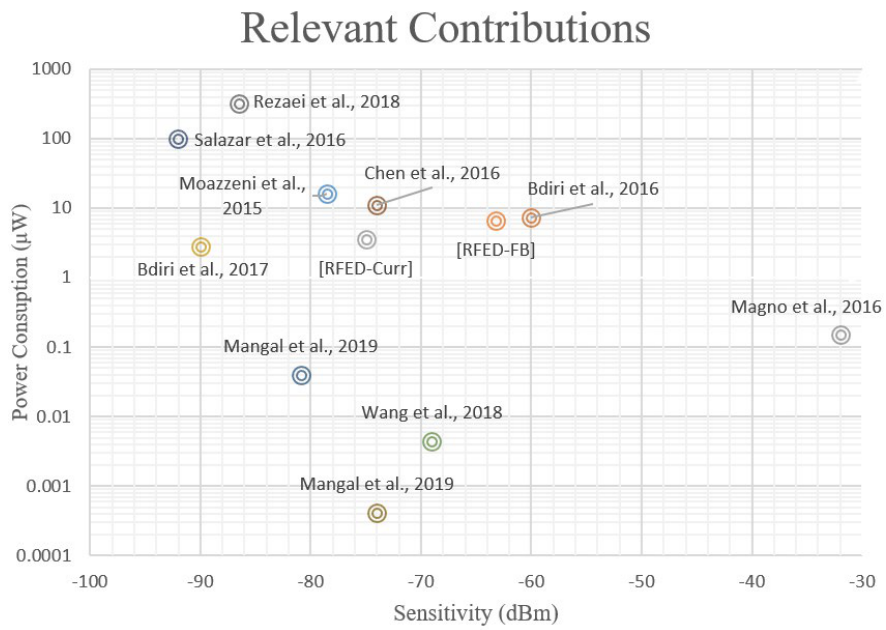
Figure 13. Representation of the performance of the proposed contributions along with some of the most relevant state-of-the-art works involving WuR